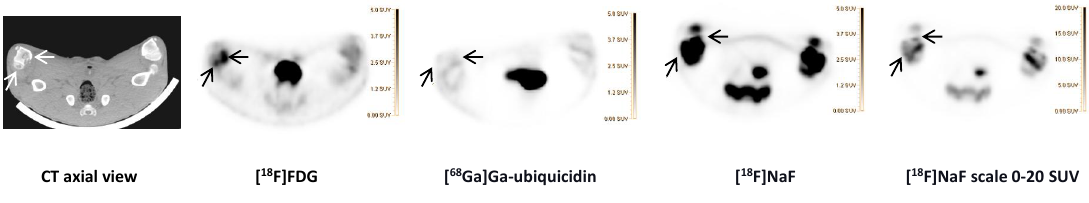
Figure 4. [ 68 Ga]Ga-ubiquicidin and [ 18 F]NaF compared to [ 18 F]FDG.